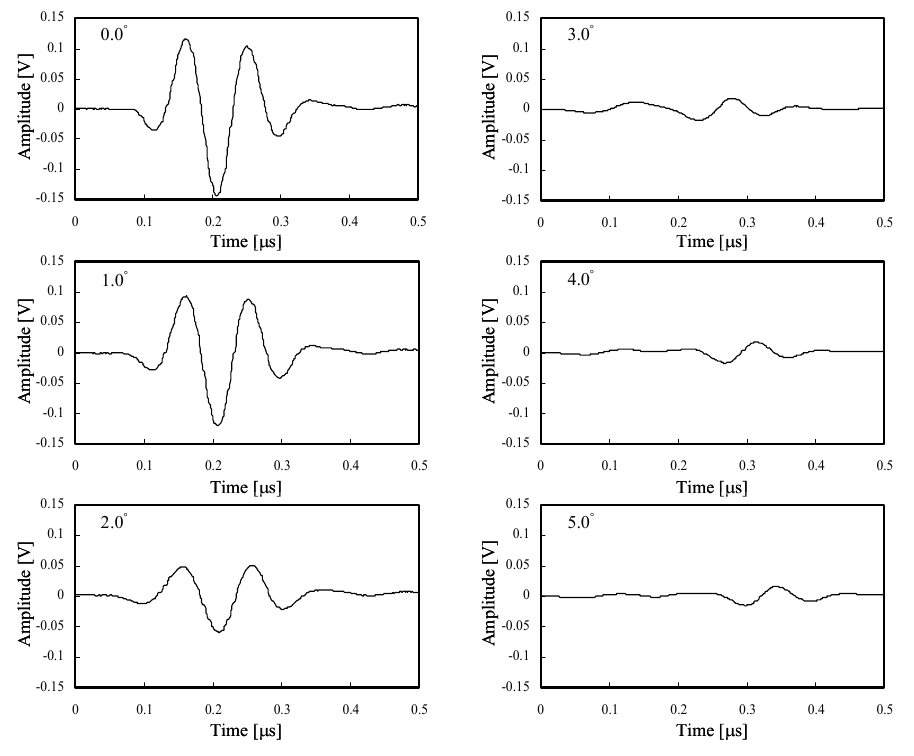
Figure 4: Deformation of echo waveforms measured using articular